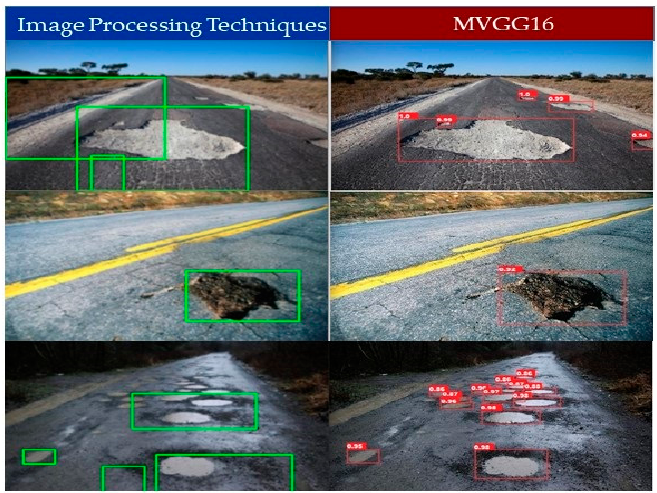
Figure 9. Pothole detection results: left column pothole detection using image processing techniques [24] and right column pothole detection using Faster R-CNN with backbone MVGG16.